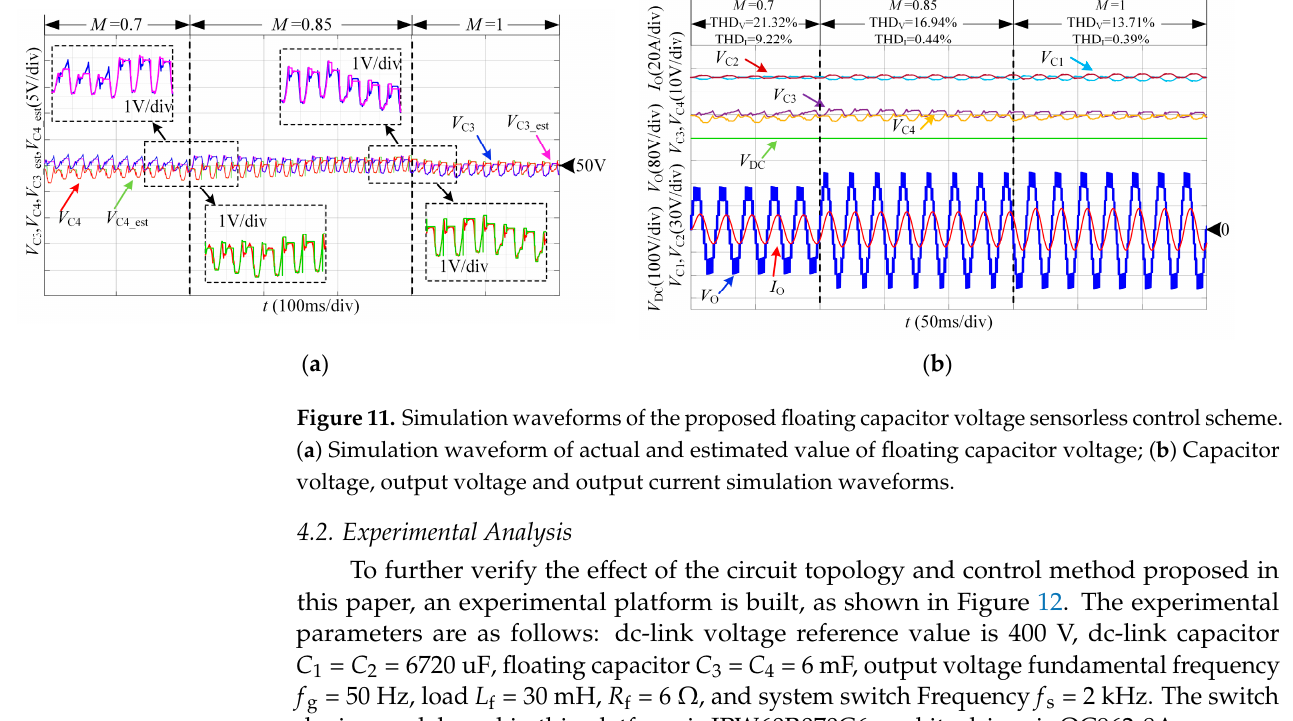
Figure 12. Scaled-down experimental platform of the proposed single-phase nine-level inverter. Figure 13 shows the experimental waveforms of the proposed topology at different modulation degrees. In Figure 13a, the experimental waveform is basically consistent with the simulation result, the output voltage is a nine-level staircase wave, and the output current has a high sine degree. Due to the influence of the load inductance L f , the current lags the voltage. It can be seen that the nine-level topology has good output performance. It can be seen from Figure 13b that V C1 and V C2 are both stable at about 200 V, and the voltage fluctuation range is ±12 V. It can be seen from Figure 13c that V C3 and V C4 are both stable at about 50 V, and the voltage fluctuation range is ±4 V.